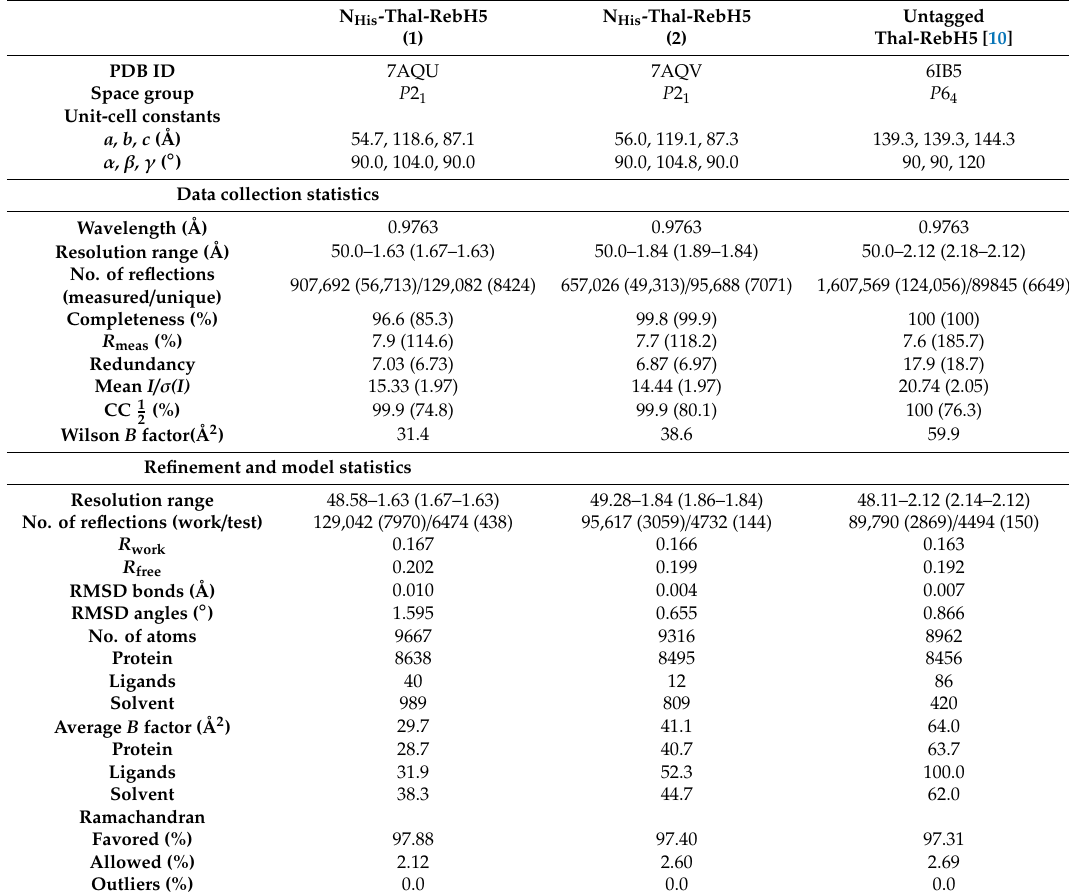
Table 1. Data collection and refinement statistics. The statistics of the deposited structure Thal-RebH5 (6IB5) lacking a His-tag [10] is listed for